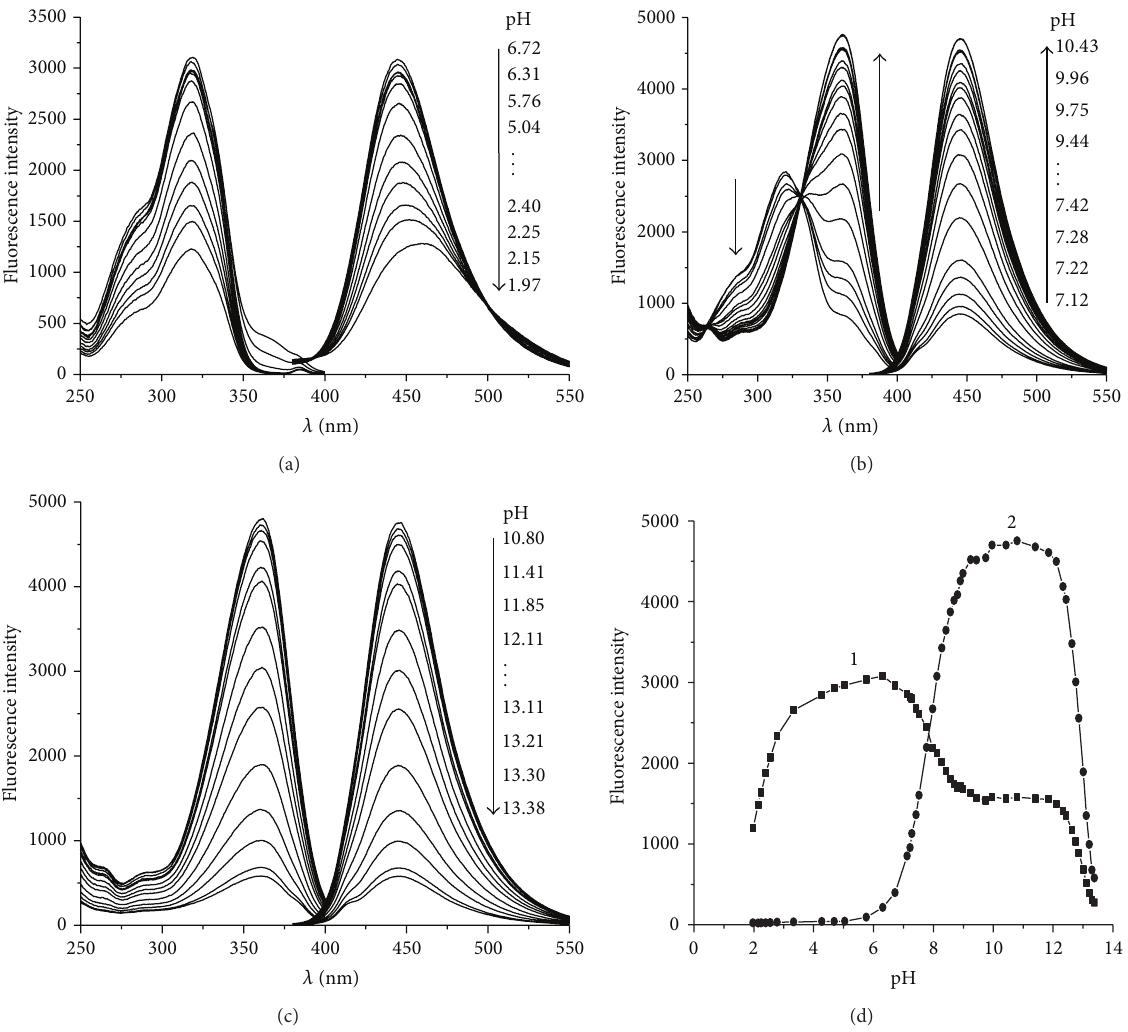
Figure 2: (a), (b) and (c) Fluorescence excitation and emission spectra of 4MU at different pH and (d) relationship between fluorescence /𝜆 : (a) and (d(1)): 320 nm/445nm, (b), (c) and (d(2)): 360 nm/445 intensity and pH. c 4 MU : 18.5 ng mL −1 ; 𝜆 ex em